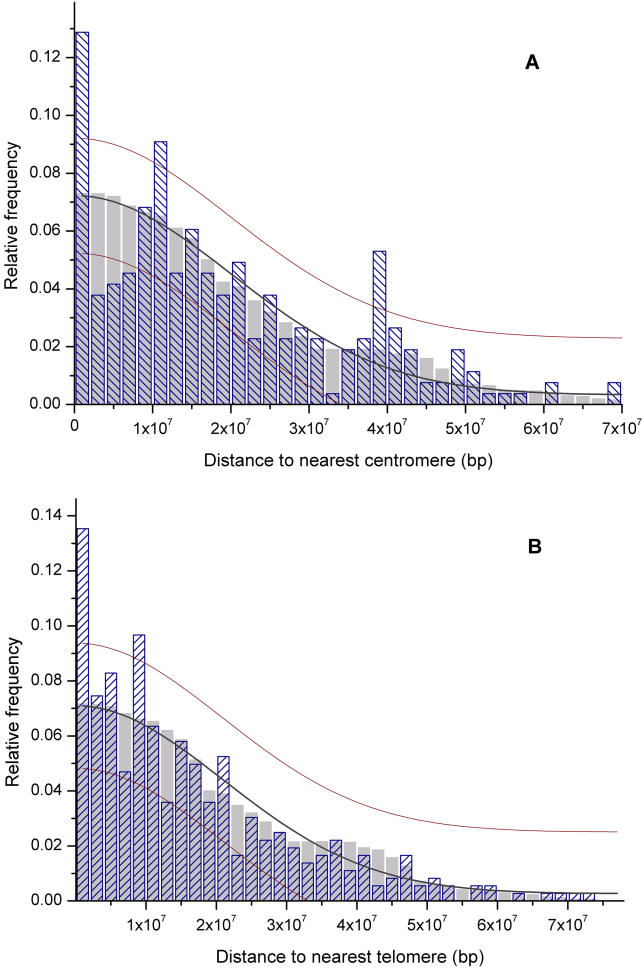
Relative Frequency Histograms of Distances from Human CNVs to the Nearest Centromere or TelomereRelative frequency histograms (striped blue bars) are compared to their expected distributions if CNVs were distributed randomly within the genome (grey bars); these expected distributions are fitted to Gaussian distributions (grey lines). Red lines represent 99.9999% prediction confidence intervals from the fitted curves.